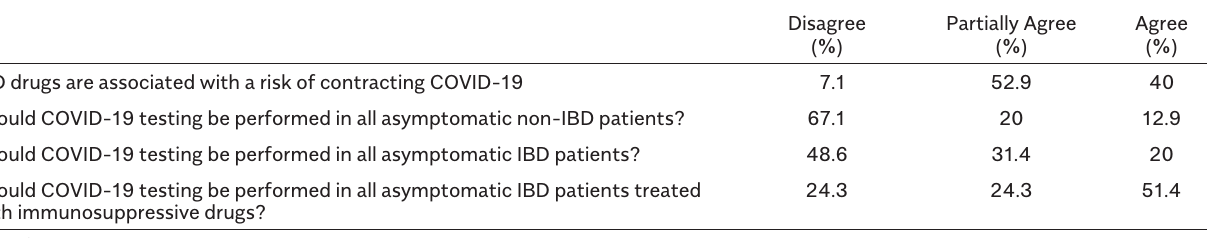
Table 3. Questions and Answers About the Effect of IBD Medications on COVID-19 and COVID-19 Testing in IBD